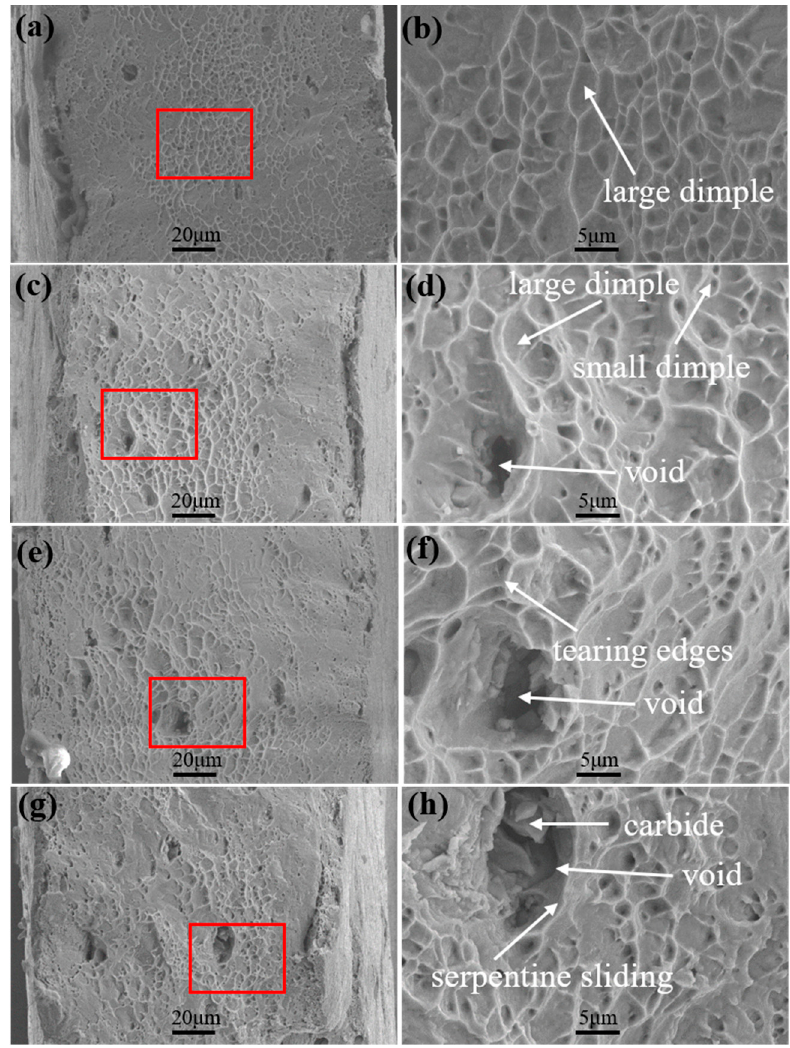
Figure 10. Fracture morphologies of specimens. ( a , b ) Specimen A; ( c , d ) specimen B; ( e , f ) specimen C; ( g , h ) specimen D.